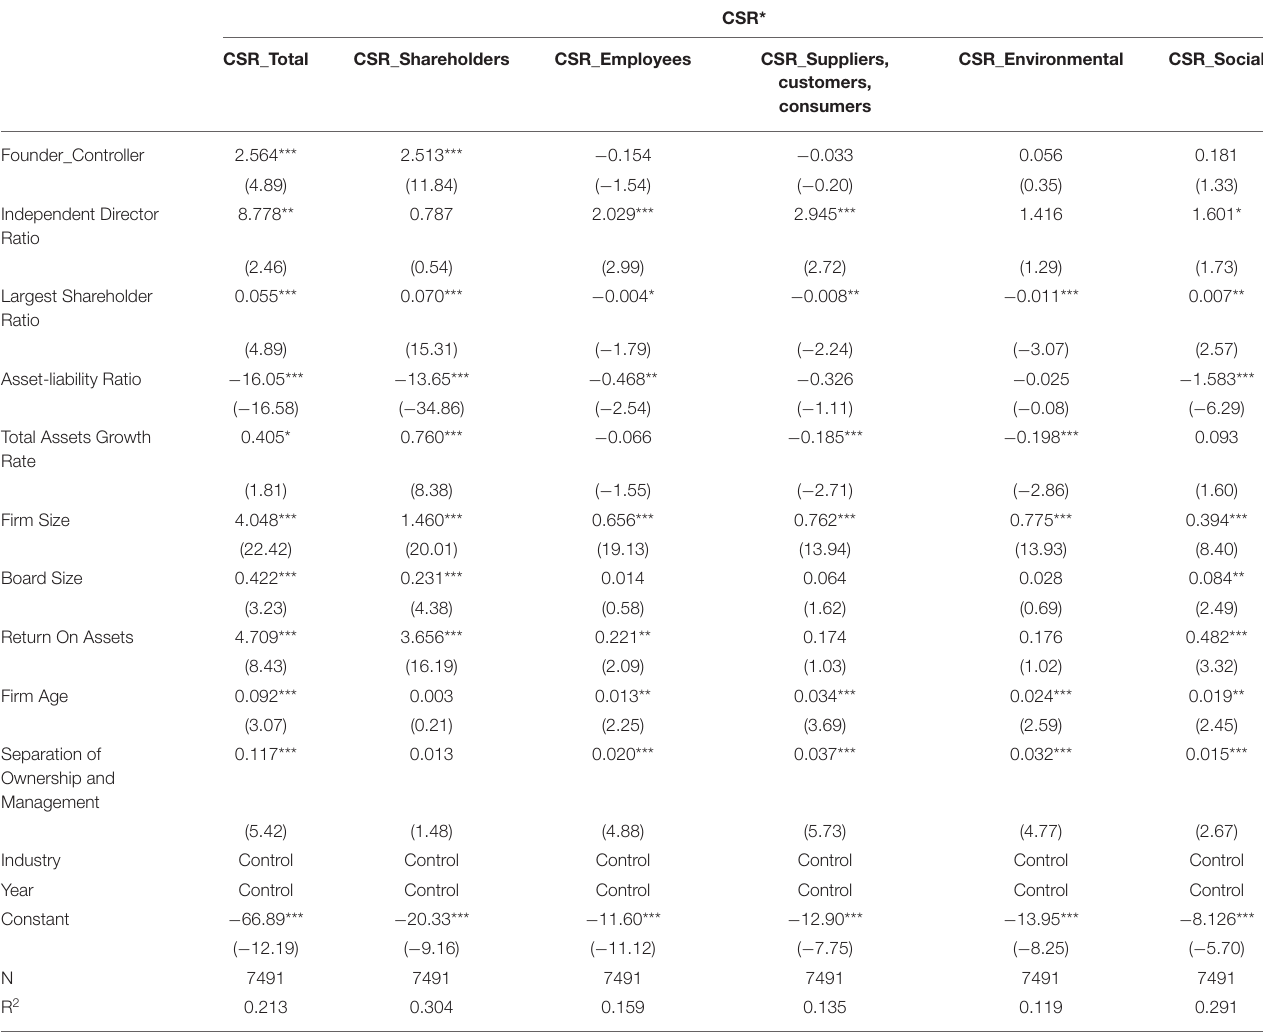
TABLE 8 | Regression results (founder actual controller and